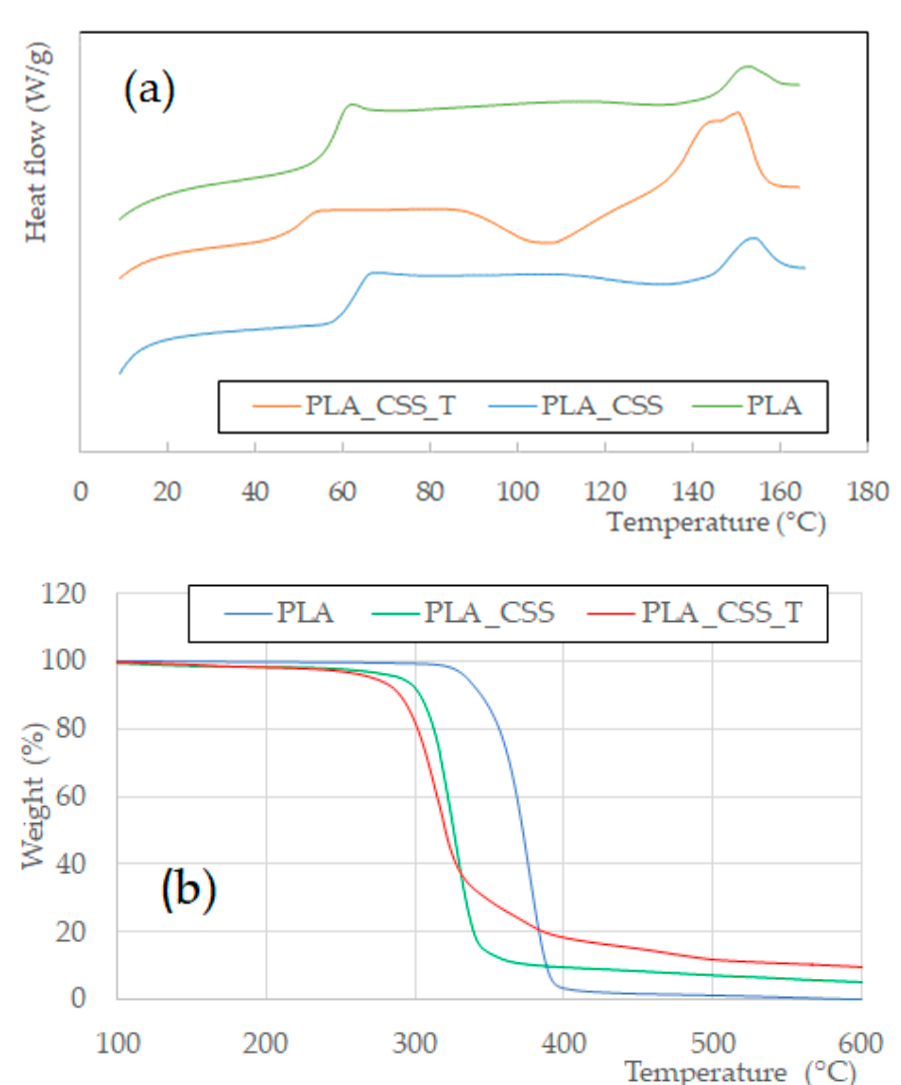
Figure 3. ( a ) thermograms derived by DSC; ( b ) TGA analysis.